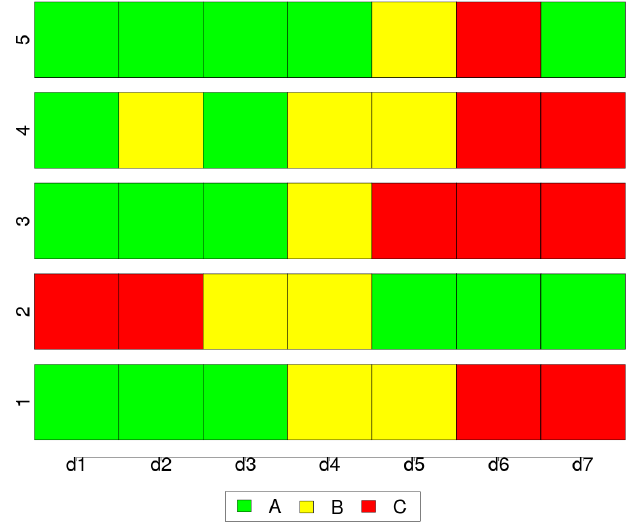
Figure 1. Sequences of five